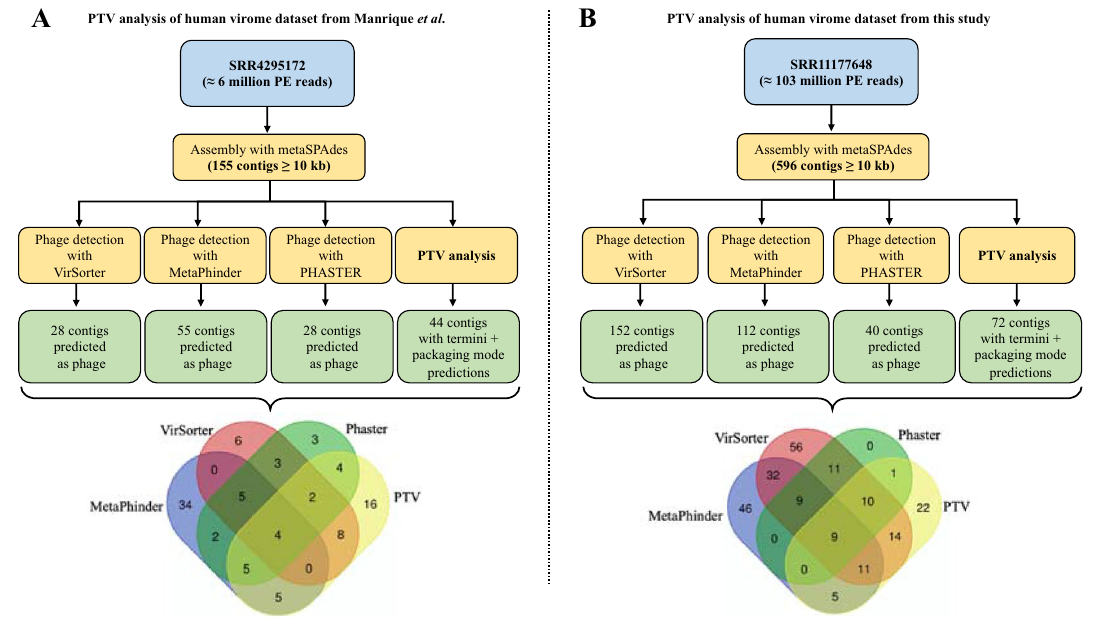
Figure 3. PhageTermVirome analysis with two human virome datasets. ( A ) PTV analysis of 155 contigs assembled from the study of Manrique et al. ( B ) PTV analysis of 596 contigs assembled from the virome dataset generated for this